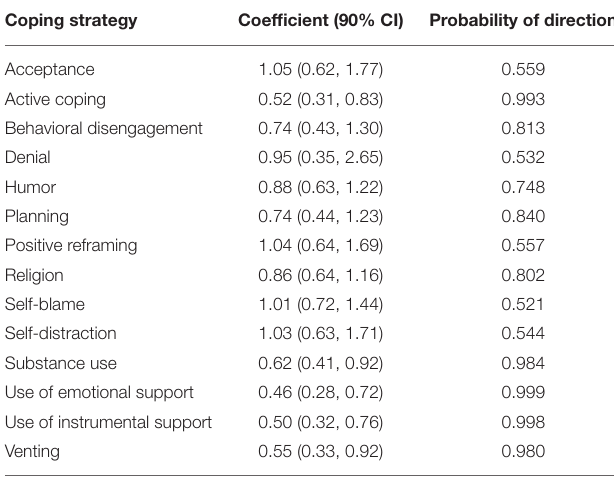
TABLE 2 | Coefficients and probability of direction associated with response